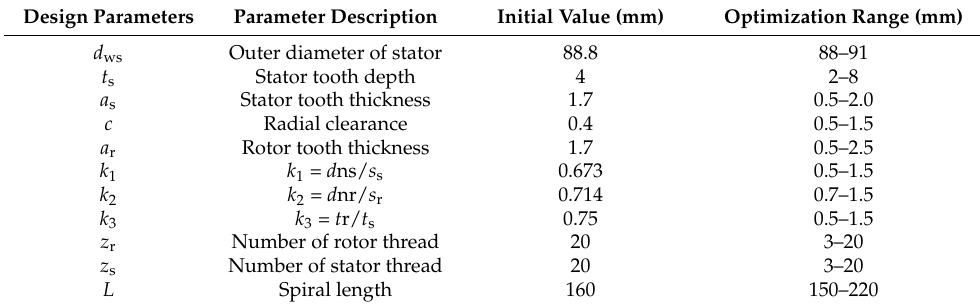
Table 2. Design parameters and value range. Design